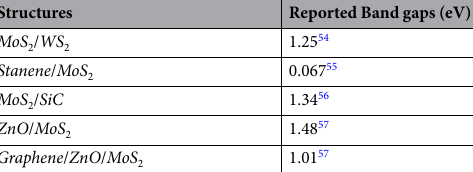
Table 1. Band gap ( E g ) of other heterostructures based on MoS 2 .